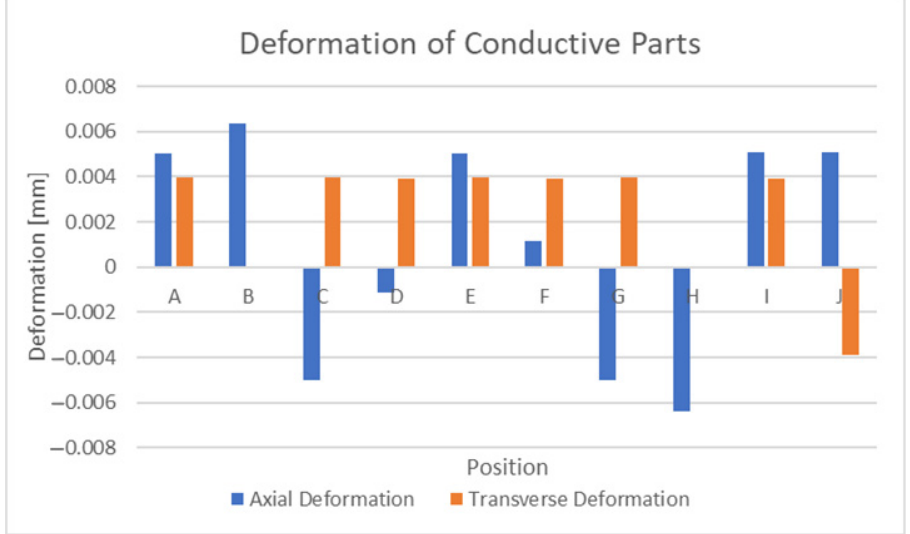
Figure 18. Deformation of isolated conductive elements at 350 °C.